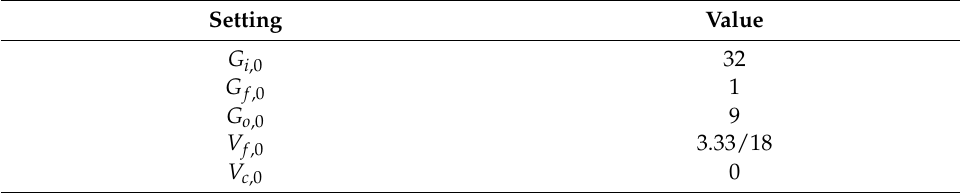
Table 2. Default parameter settings for the PGA309 amplifier transfer function (see Equation (8)) converting a pair of probing voltages from a gauge bridge into a larger output voltage. Setting Value G i ,0 32 G f ,0 1 G o ,0 9 V f ,0 3.33/18 V c ,0